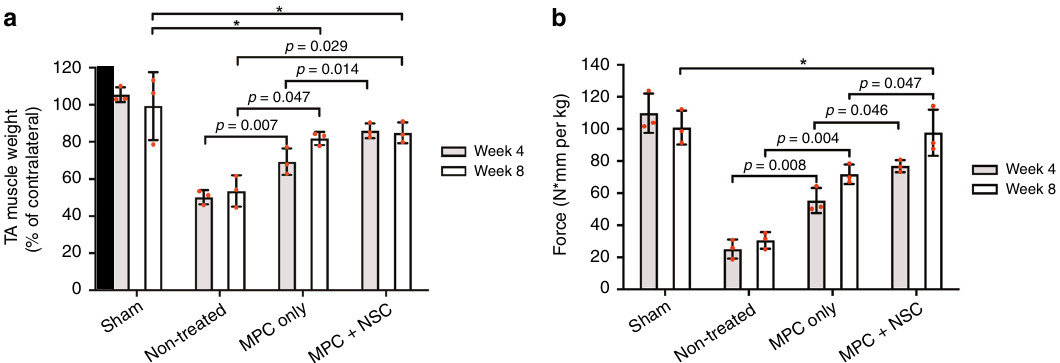
Fig. 4 Functional restoration by 3D bioprinted human skeletal muscle constructs implanted in the rat model of tibialis anterior (TA) muscle defect at 4 and 8 weeks after implantation. a TA muscle weight (% of contralateral normal TA muscle) ( n = 3 per group and time point, triple measures per sample). b Tetanic force (N·mm per kg) ( n = 3 per group and time point, triple measures per sample). All data are represented as mean ± SD. The p -values by two- way ANOVA followed by Tukey ’ s test are indicated. *no signi fi